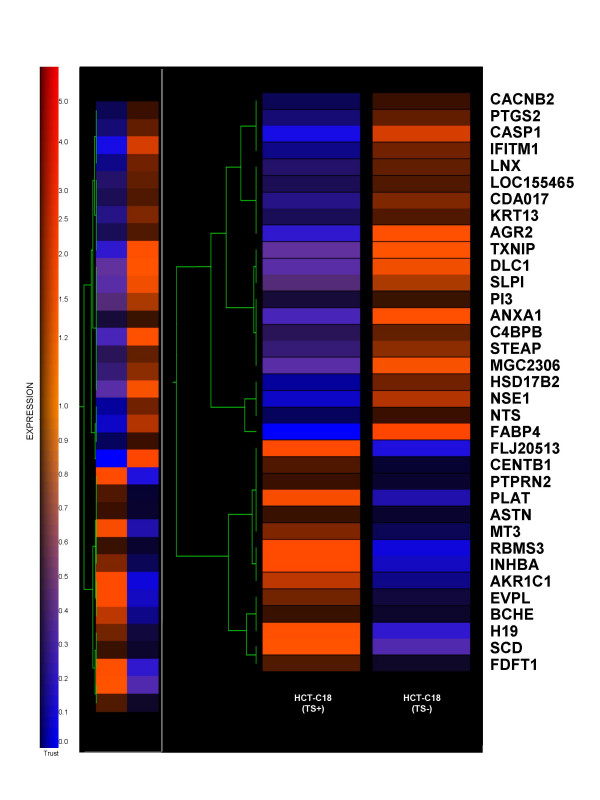
Clustering analysis of genes expression affected by TS overexpression with HCT-C18 (TS+) (Lane 1) vs. HCT-C18 (TS-) (Lane 2) based on the profiles of steady state total mRNAs. One-way ANOVA analysis was used for the gene clustering with p < 0.05.